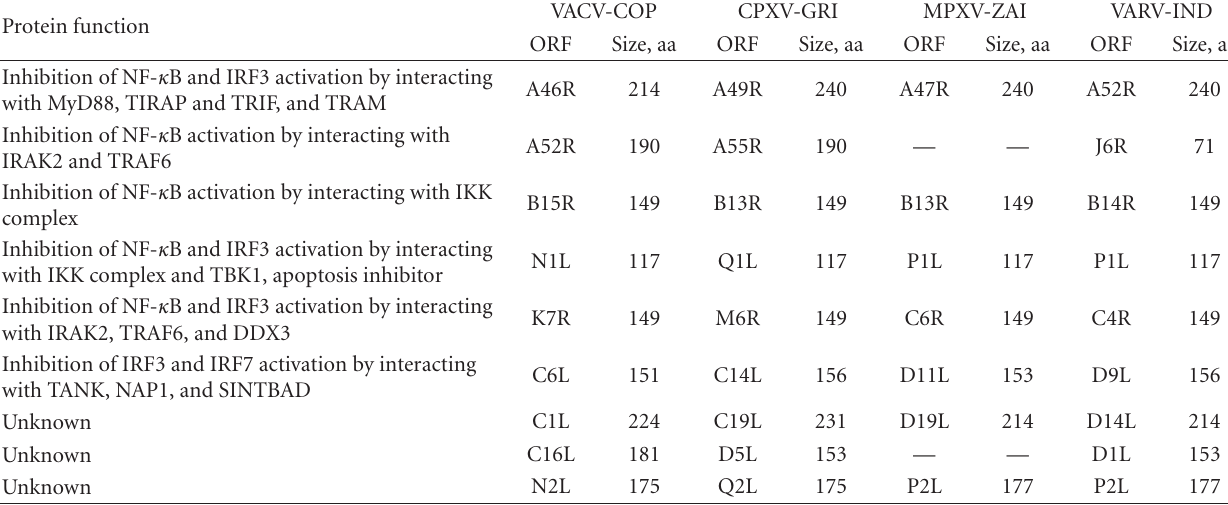
Table 1: Orthopoxviral Bcl-2-like